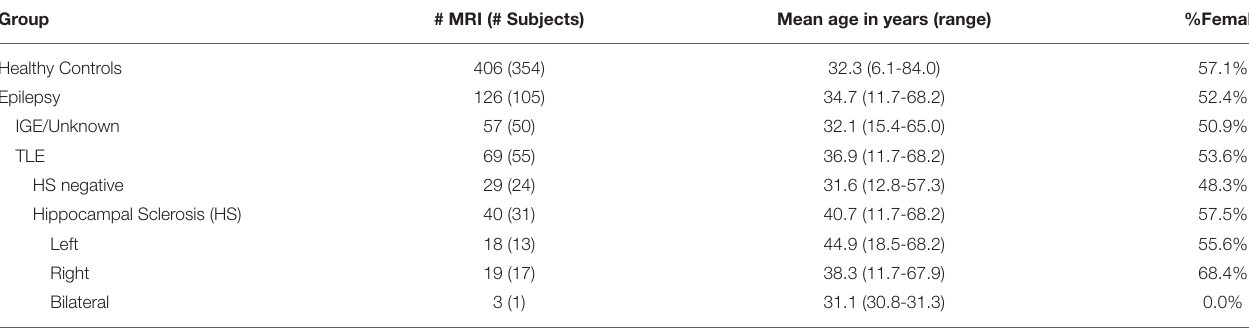
Indented groups show a subset of parent line. Statistics for age and sex are calculated over the MRI samples at the time of acquisition. Corresponding information on a subject level can be found in Supplementary Table S1 . IGE, idiopathic generalized epilepsy; TLE, temporal lobe